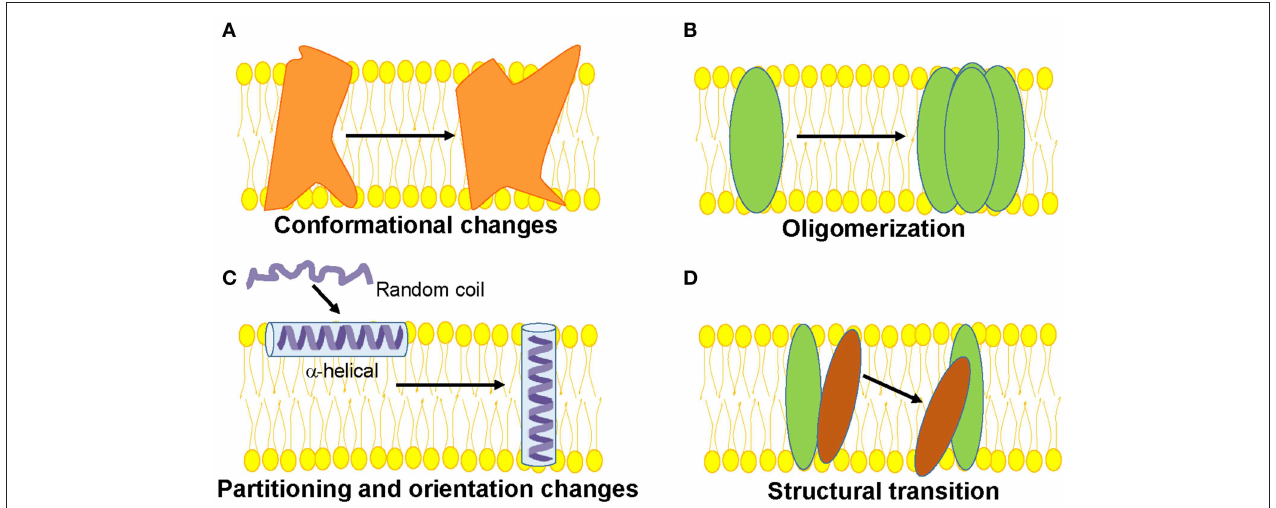
FIGURE 1 | Schematic representations of functionally-relevant structural changes in membrane proteins are shown. (A) Conformational changes in response to a physiological signal such as voltage, ligand, pH, membrane tension etc. (B) Oligomerization involving protein-protein interactions, (C) Partitioning, folding and insertion of membrane proteins such as pore-forming proteins (D) Lipid-protein interactions resulting in structural